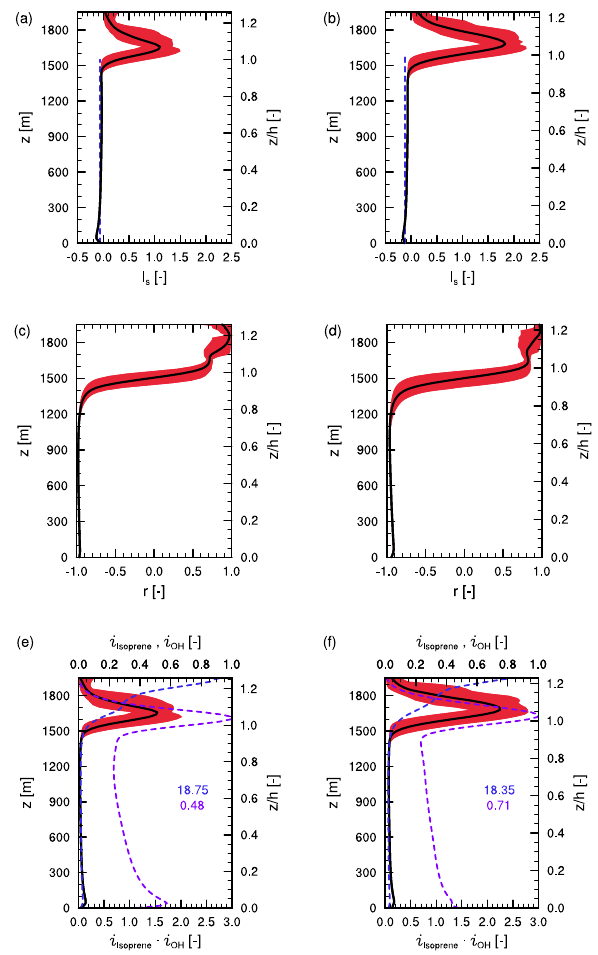
Fig. 6. Horizontal intensities of segregation and the contributing components, evaluating the isoprene-OH reaction. The fourth hour of the numerical experiments HOM (a, c, e) and HET (b, d, f) is evaluated. At every height the instantaneous intensity of segrega- tion over the horizontal plane is determined at intervals of 1min. Its averages are shown in (a) and (b) with the variability in time depicted using the red shading. The intensity of segregation over the entire boundary layer is shown by the blue dashed line. In (c) and (d) the horizontal spatial correlations between isoprene and OH are shown with their temporal variability. In (e) and (f) this is also done for the product of the concentration fluctuation intensities of OH and isoprene, i.e. the second term in Eq. (12). In blue and purple dashed lines the separate concentration fluctuation intensi- ties are shown for isoprene and OH , respectively. The numbers in (e) and (f) denote their unnormalized maximum